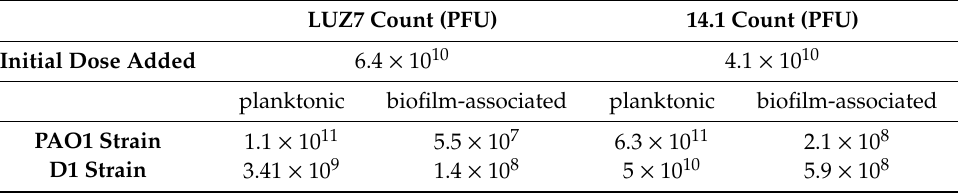
Table 9. Particle enumeration of phages during